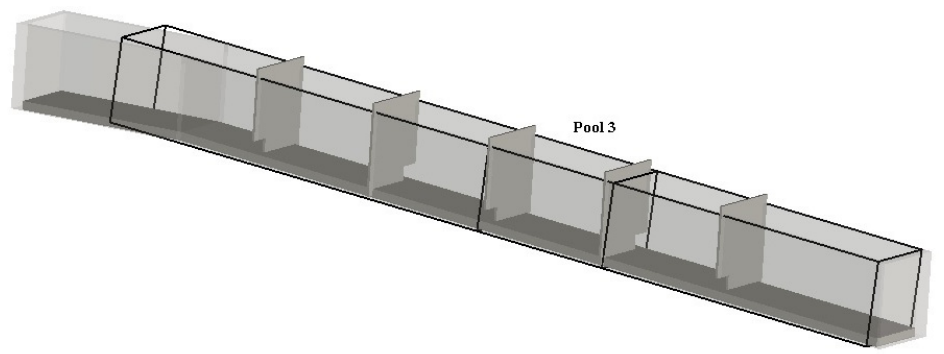
Figure 3. Computational domain, showing Pool 3 mesh block.